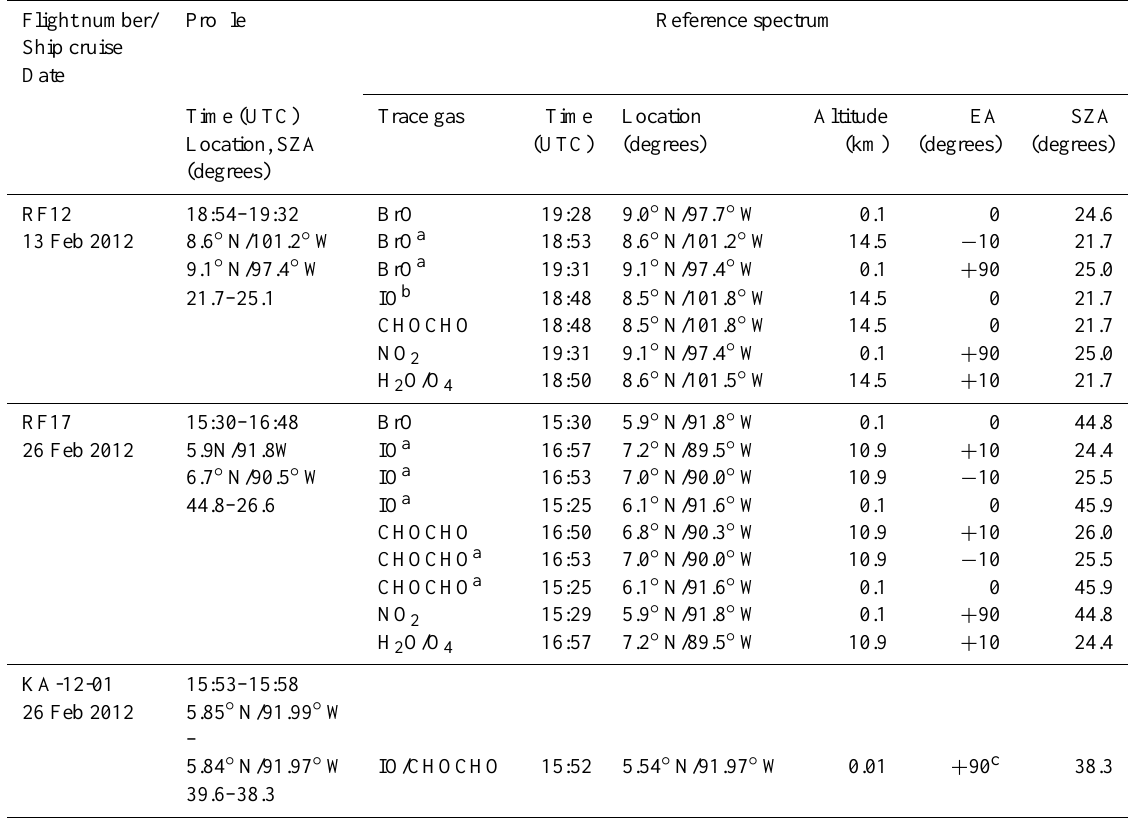
Table 2. Profile and DOAS reference details. Flight number/